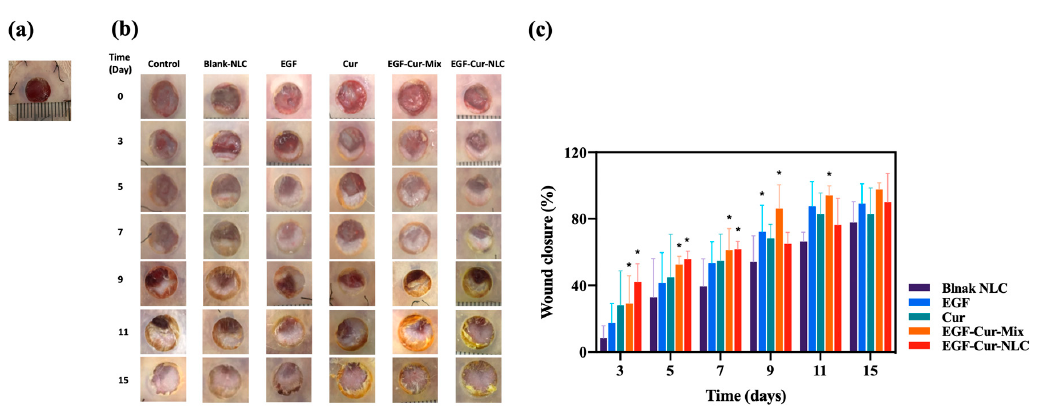
Figure 7. Chronic-wound healing effect of blank-NLC, EGF, Cur, EGF–Cur-Mix, and EGF–Cur-NLC in diabetic rats. ( a ) Wound image with silicone splint, ( b ) wound images after the application of the formulations at day 0 and 3, ( c ) %wound closure calculated as percentage area of the initial wound; * p < 0.0.5 compared to the control group.